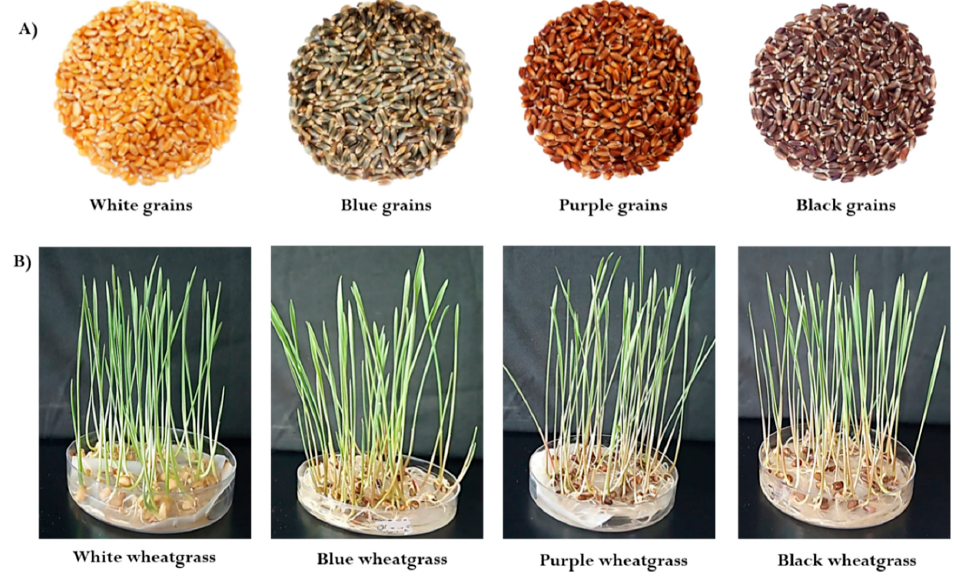
Figure 5. Different colored wheat grains ( A ); and wheat-grasses ( B ) used in the present study. Figure 5. Di ff erent colored wheat grains ( A ); and wheat-grasses ( B ) used in the present